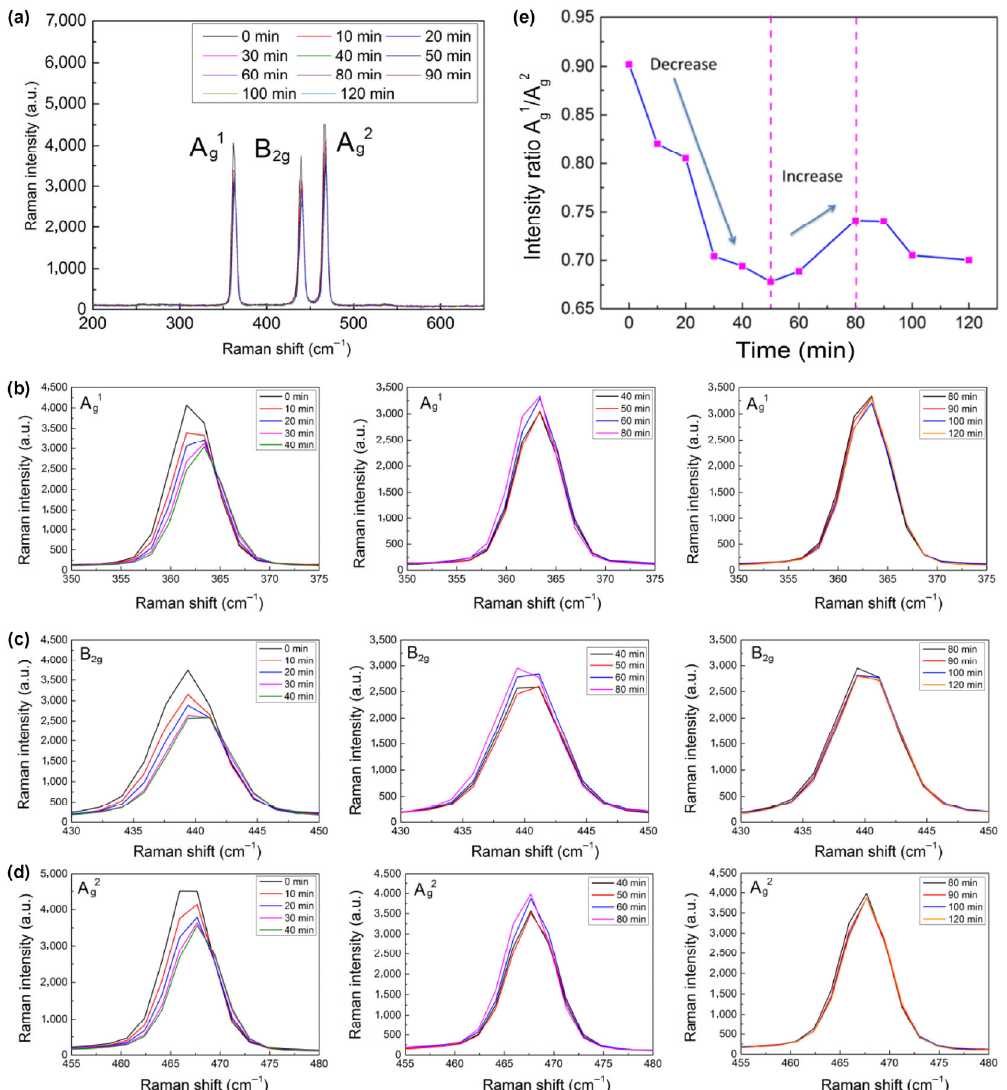
Fig. 7 The Raman characterization result of BP with air exposure time for two hours. (a) Raman spectroscopy of BP at ambient environment and various times; (b), (c) and (d) are the Raman intensities of 1 intensity ratio between 1 A and 2 A on air exposure g g